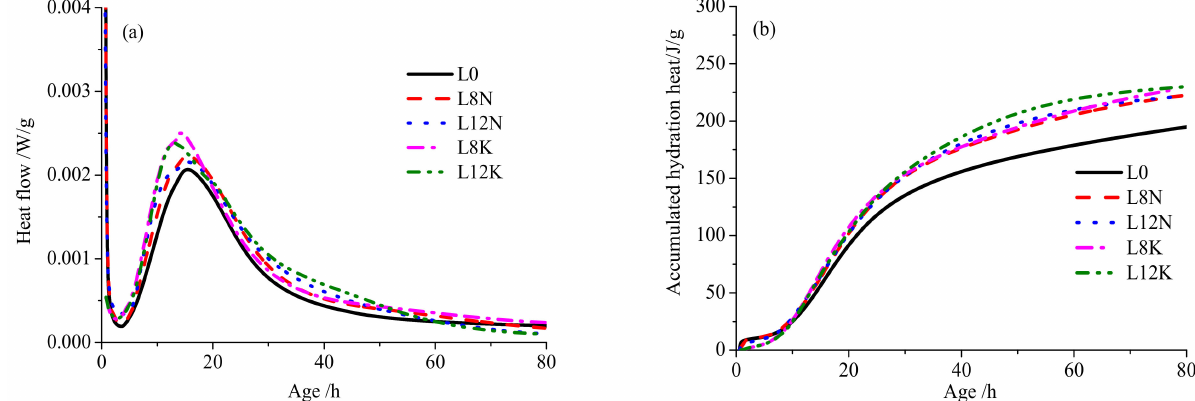
Figure 6. The heat flow ( a ) and accumulated hydration heat ( b ) of LHPC pastes with different alkali sulfates contents.